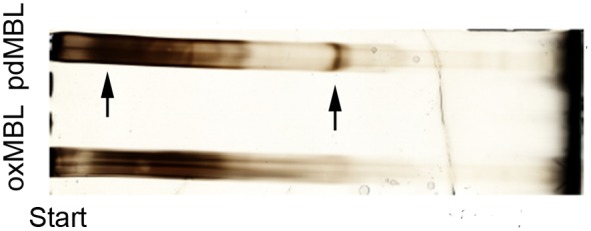
Loss of higher-order quaternary structures in oxMBL vs pdMBL.To mimic high levels of oxidative stress, pdMBL was exposed to 74′-azobis(2-methylpropionamidine)dihydrochloride (AAPH). Polyacrylamide gel electrophoresis was then applied to measure changes to MBL by separating the different MW. Protein samples were loaded 10 ug MBL per lane for blue native PAGE and visualized with silver stain. Figure shows a loss of mid-higher order oligomeric structures in oxMBL vs pdMBL.